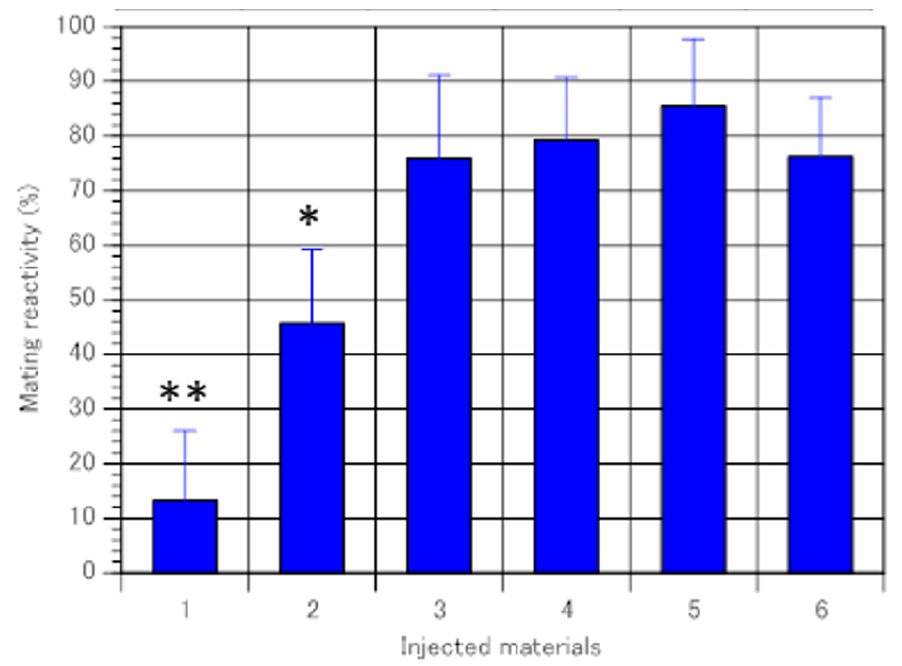
Figure 2. Inhibition of immaturin activity by the anti-immaturin antibody. The vertical axis indicates the percentage of mating reactive cells in the clones derived from recipients. The horizontal axis represents the injected samples. 1. Immaturin, 2. Immaturin mixed with anti-immaturin antibody (0.15 mg/mL), 3. Immaturin mixed with anti-immaturin antibody (0.31 mg/mL), 4. anti-immaturin antibody (0.31mg/mL), 5. Buffer solution, 6. Without injection. Data represent the average percentage of mating reactive cells ± SD (n = 6). Tukey’s multiple comparison test: * p < 0.05, ** p < 0.01.